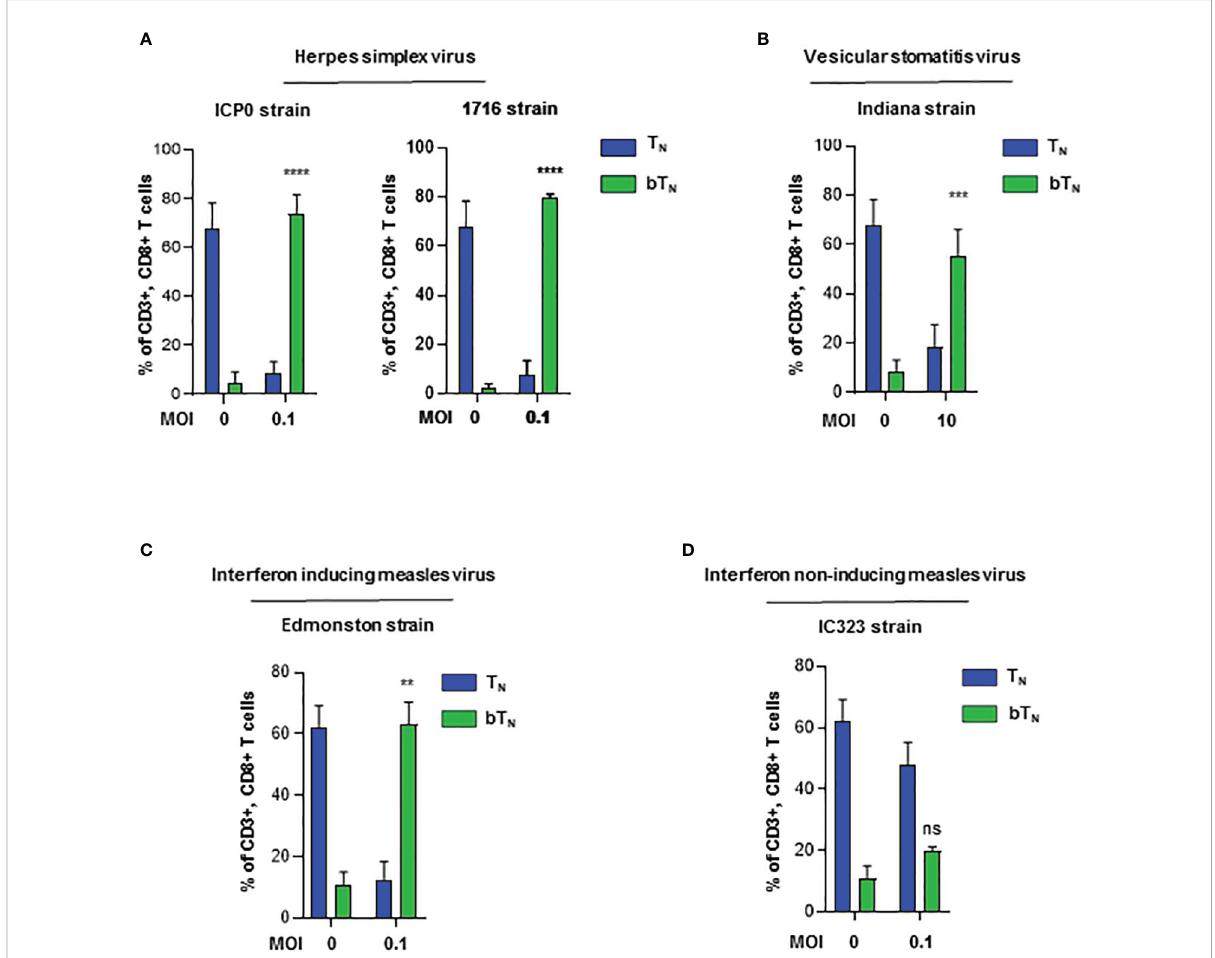
FIGURE 4 Induction of CD8 bT N cells ex vivo upon exposure to different viruses. Bar graphs showing the induction of CD8 bT N cells upon ex vivo exposure of C57BL/6 splenocytes to (A) two different strains of herpes simplex virus (ICP0 and 1716, n=3 independent experiments each) at MoI = 0.1, (B) vesicular stomatitis virus (Indiana strain, n=3 independent experiments) at MoI = 10, (C) interferon activating strain of measles (Edmonston, n=2 independent experiments) at MoI = 0.1 and (D) wild type strain of measles (IC323, n=2 independent experiments) at MoI = 0.1. Two-way ANOVA with Sidak ’ s multiple comparisons test and 95% con fi dence interval was used for statistical analysis in bar graphs. Signi fi cance has been indicated only for CD8 bT N cell populations induced within 24 hours in comparison with untreated control population levels. Not signi fi cant (ns) = p > 0.05; **p < 0.01; ***p < 0.001; **** p